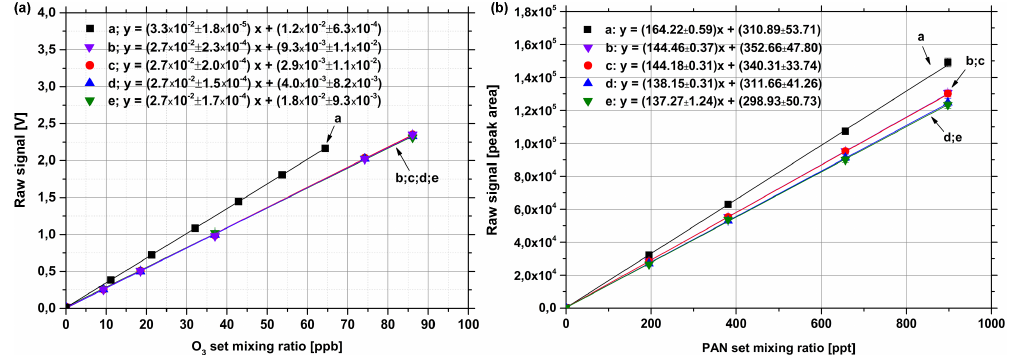
Figure 7. Multipoint calibration curve of O 3 (left) and PAN (right) at different sampling positions: (a) without setup, (b) inlet of the sample cuvette, (c) inlet of the reference cuvette, (d) outlet of the sample cuvette, (e) outlet of the reference cuvette. The linear fit equations are given with the error of slope and offset.